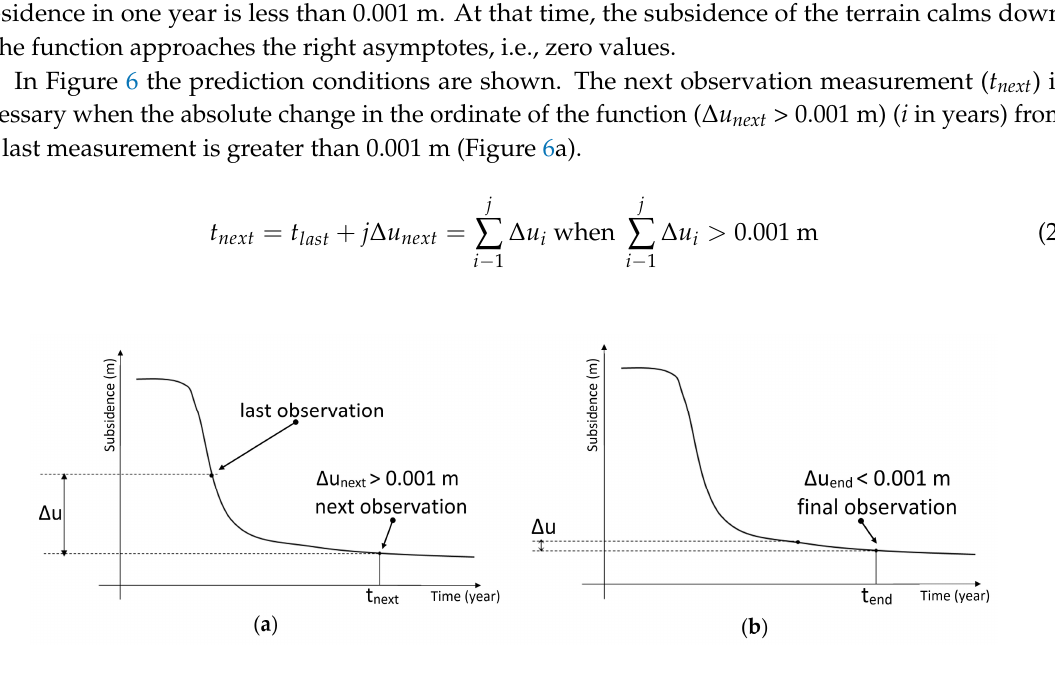
Figure 6. The prediction conditions for: ( a ) the next observation measurement, when 𝛥𝑢 (cid:3041)(cid:3032)(cid:3051)(cid:3047) > 0.001 m; ( b ) the final observation measurement, when 𝛥𝑢 (cid:3032)(cid:3041)(cid:3031) < 0.001 m. ( b ) the final observation measurement, when ∆ u end < 0.001